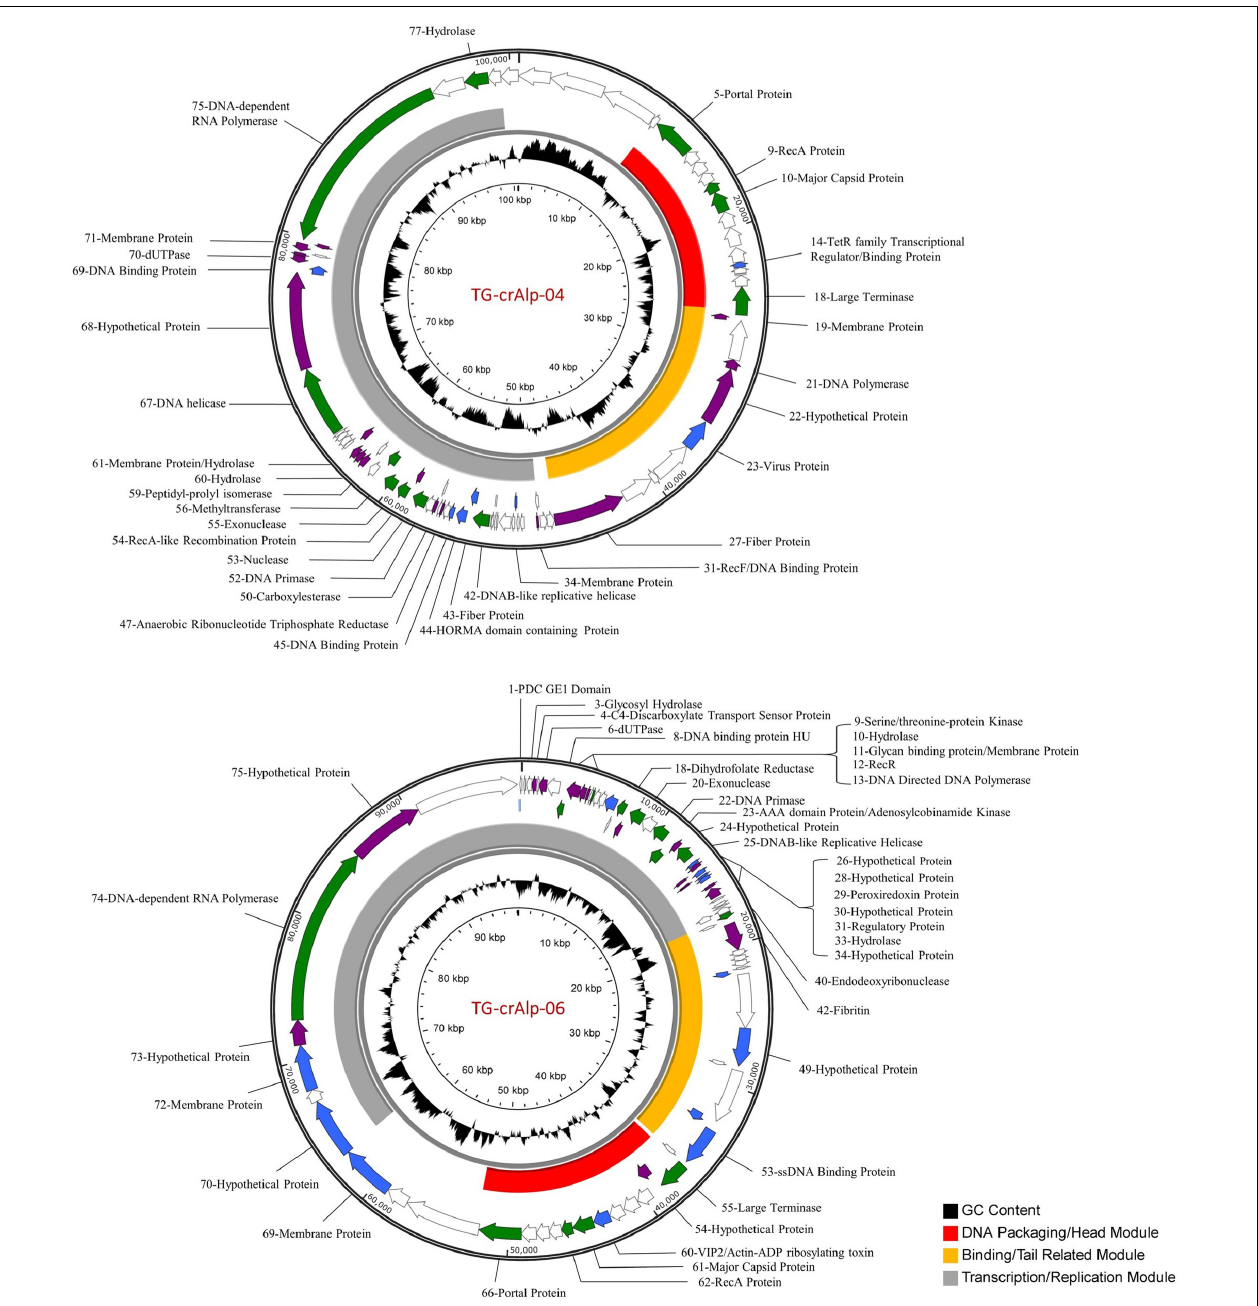
FIGURE 1 | Genome maps of Termite gut crAss-like Phages (TG-crAlp 04 and 06). The outer ring shows orientation of individual genes with color-coded probability of homology: green ≥ 95%, purple 70–95%, blue 50–70%, white < 50%. The middle ring represents phage functional modules (Keary et al., 2014; Koonin and Yutin, 2020). The inner ring displays the GC content. Detailed annotation information is provided in Supplementary Table 4 (for Phage TG-crAlp-04) and S5 (for Phage TG-crAlp-06).